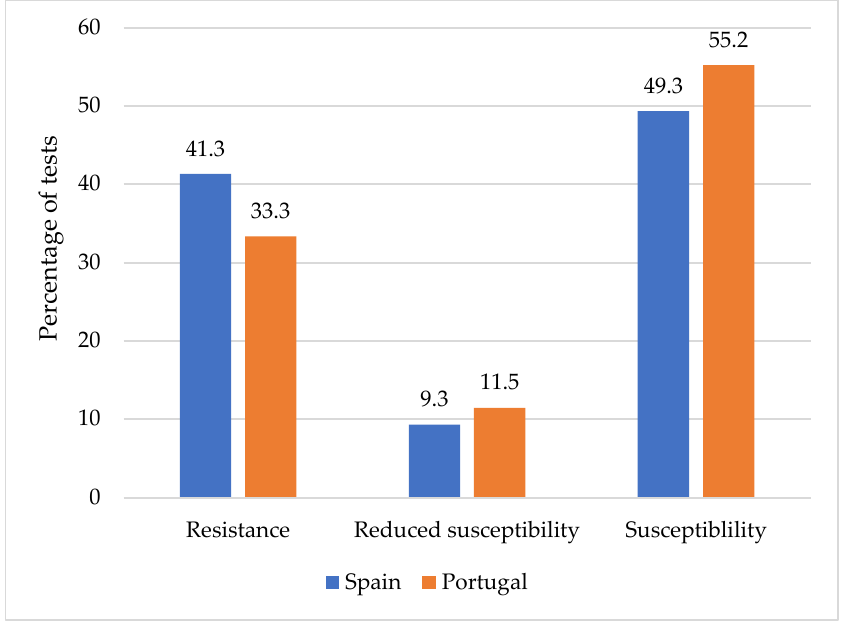
Figure 2. Percentages of tests recording resistance, reduced susceptibility, and susceptibility in strains of Listeria monocytogenes from Spanish and Portuguese minced chicken samples.